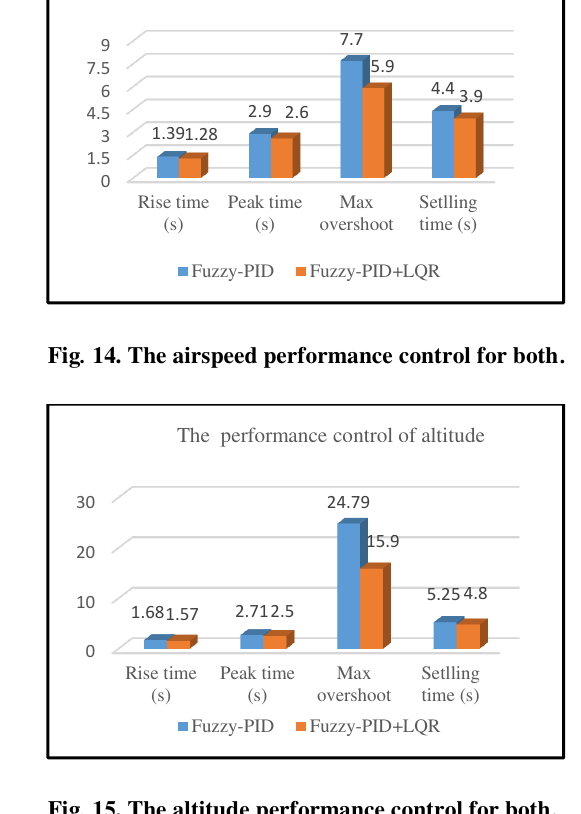
Fig . 15. The altitude performance control for both .